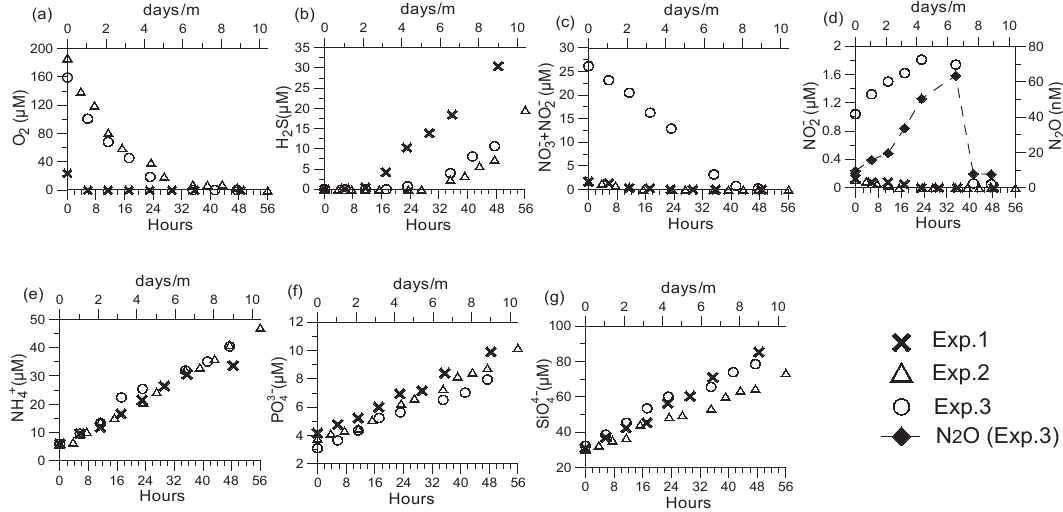
Fig. 3. . Fig. 3. . Figure 3. Variation of parameters with the integral of time/water column height (in days/meter) in the incubations during October 2005: (a) dissolved oxygen, (b) H 2 S, (c) NO −